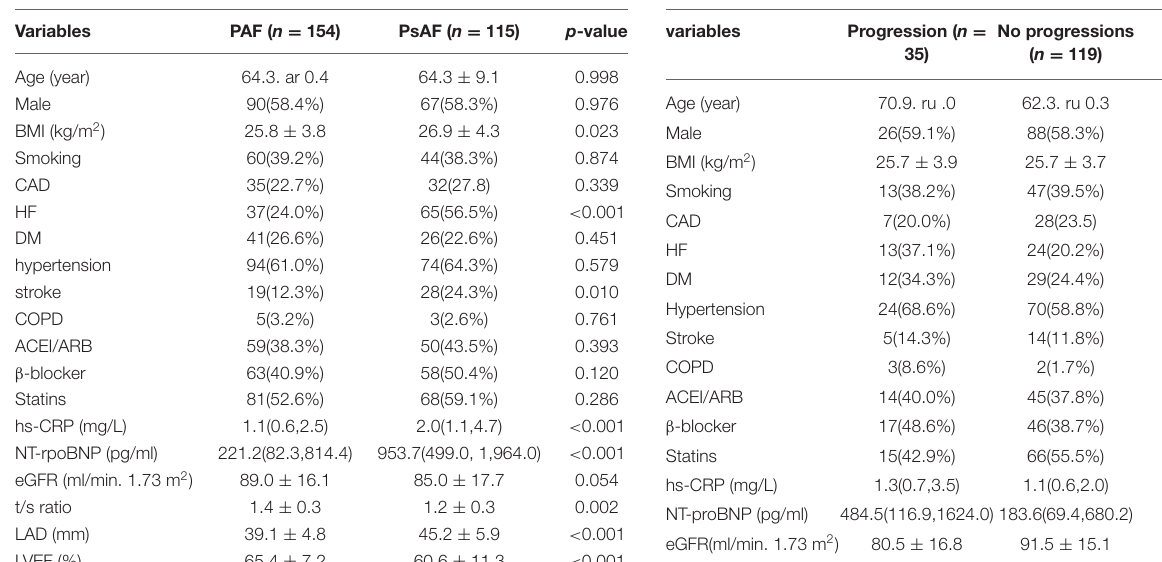
TABLE 1 | Baseline characteristics by AF type.